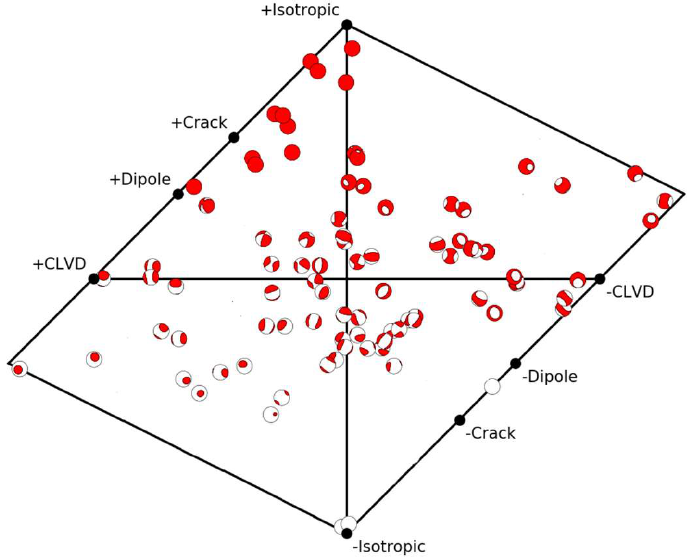
Figure 19. Hudson’s source type of coal failure under water pressure.